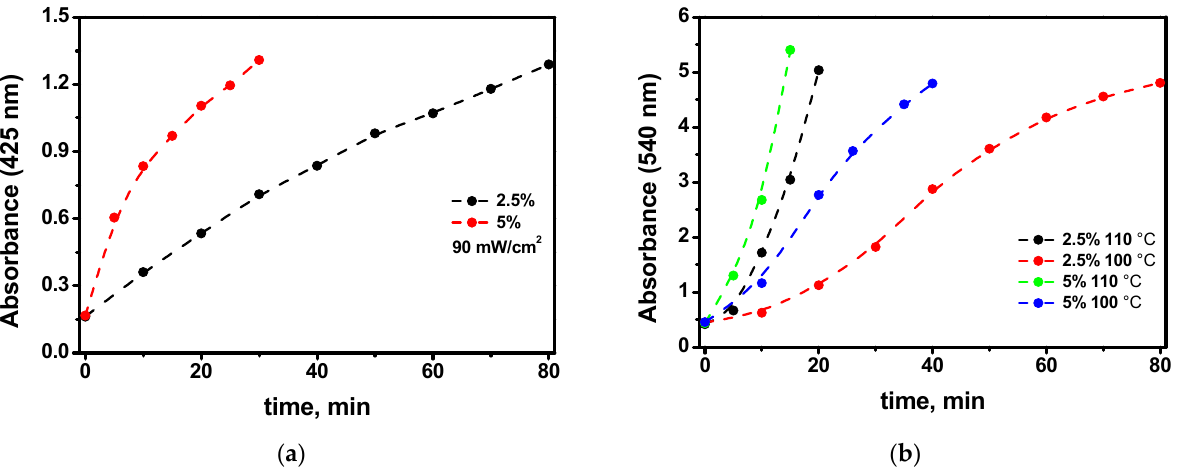
Figure 8. ( a ) The kinetics of absorbance growth at a wavelength of 425 nm for 2.5% and 5% films upon irradiation with a 365 nm UV LED. ( b ) The kinetics of the increase in absorbance at a wavelength of 540 nm upon heating at 100 and 110 °C after irradiation of 5% of the film for 30 min, and 2.5% of the film for 80 min at 90 mW/cm 2 (so that the absorption of the films after irradiation is the same).